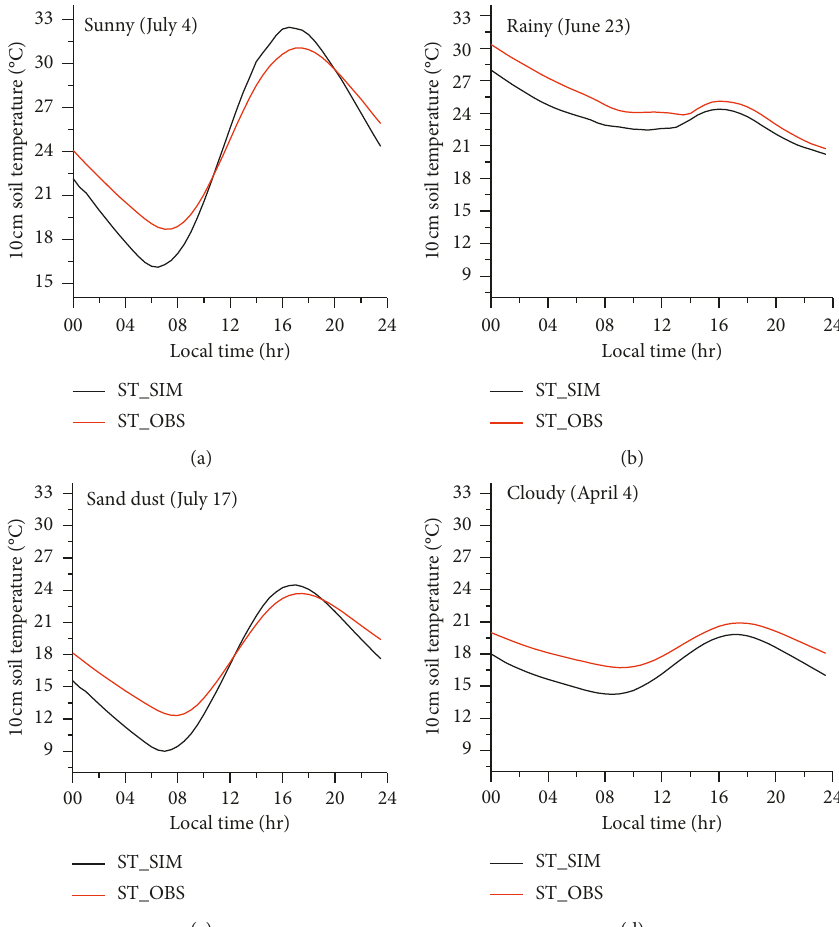
Figure 2: Contrast curve between the simulated (red) and observed (black) soil temperature (ST) for soil at a depth of 10cm in four weather conditions at the Tazhong station in 2014.